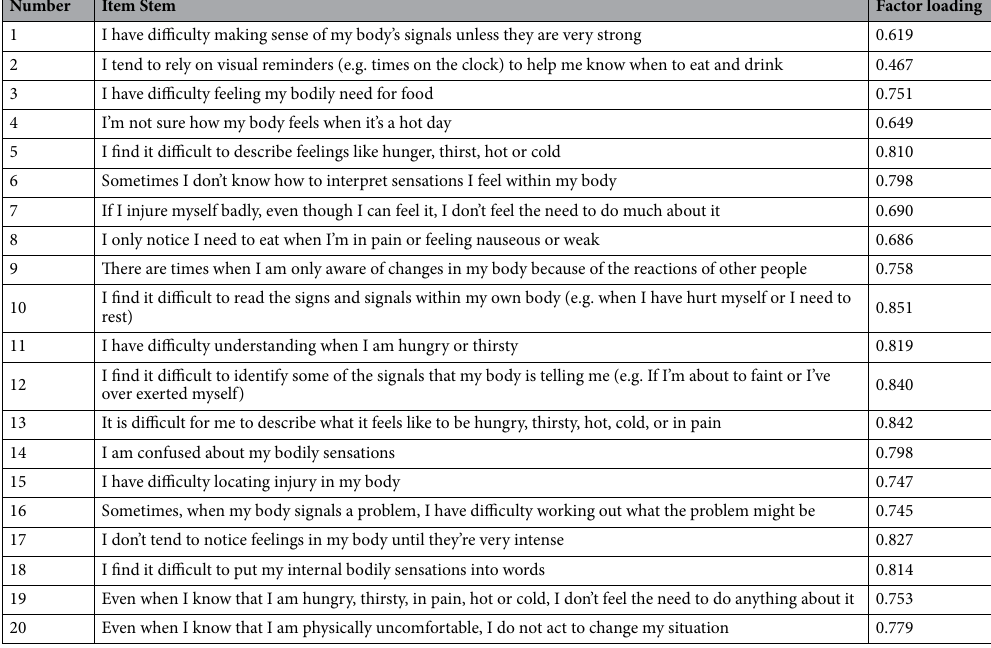
Table 3. Principal axis factor loadings for 20 ISQ items.